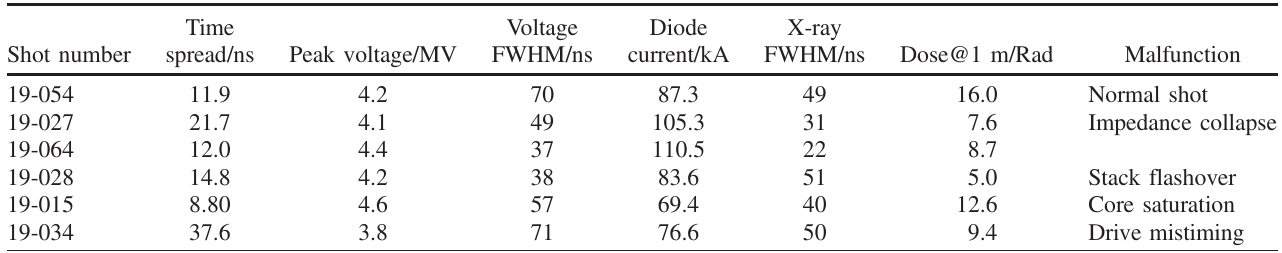
TABLE I. Comparison of 4 MV IVA output parameters of good and poor shots. The time spreads in the second column indicate the first-to-last spread of four drive pulses and represent drive synchronization. Shot